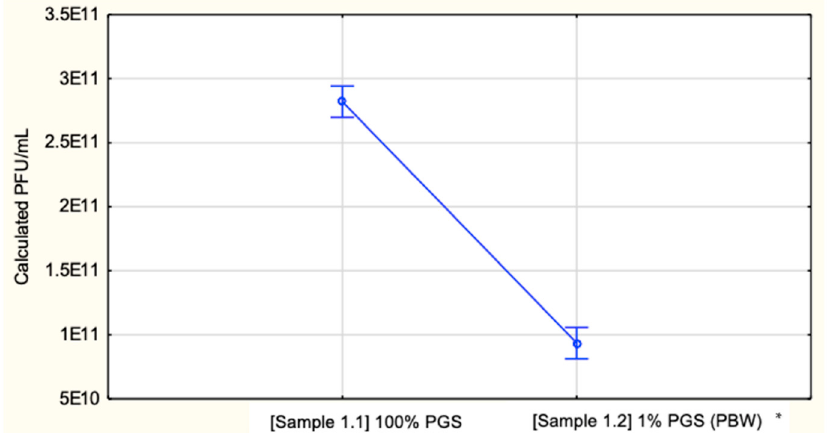
Figure 2. Calculated PFU/mL before and after dilution to 1% (PBW) (samples 1.1. and 1.2., respec- tively). * To draw parallels between sample counts of 1.1 and 1.2, sample 1.2 (1% dilution = 9.35 × 10 8 ) was calculated to reflect a theoretical stock concentration (undiluted).